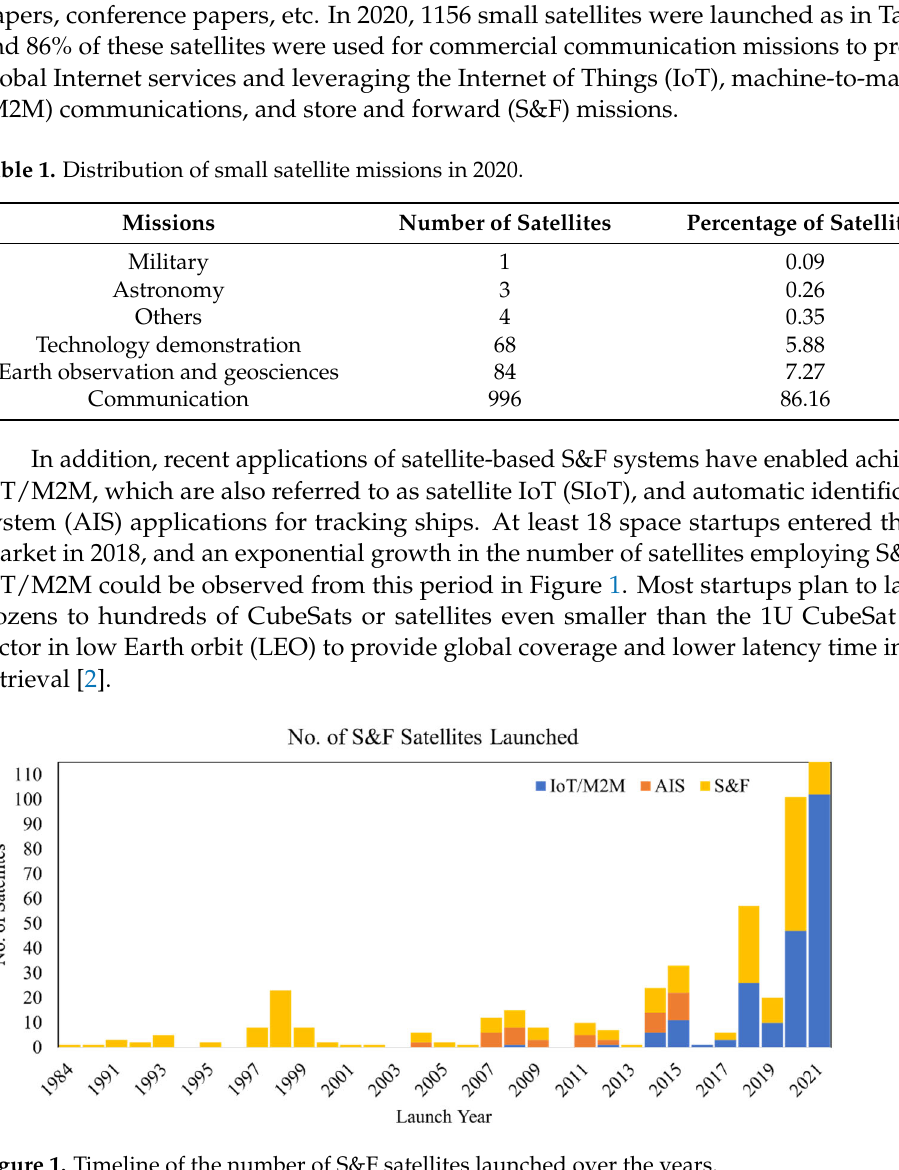
Figure 1. Timeline of the number of S&F satellites launched over the years.